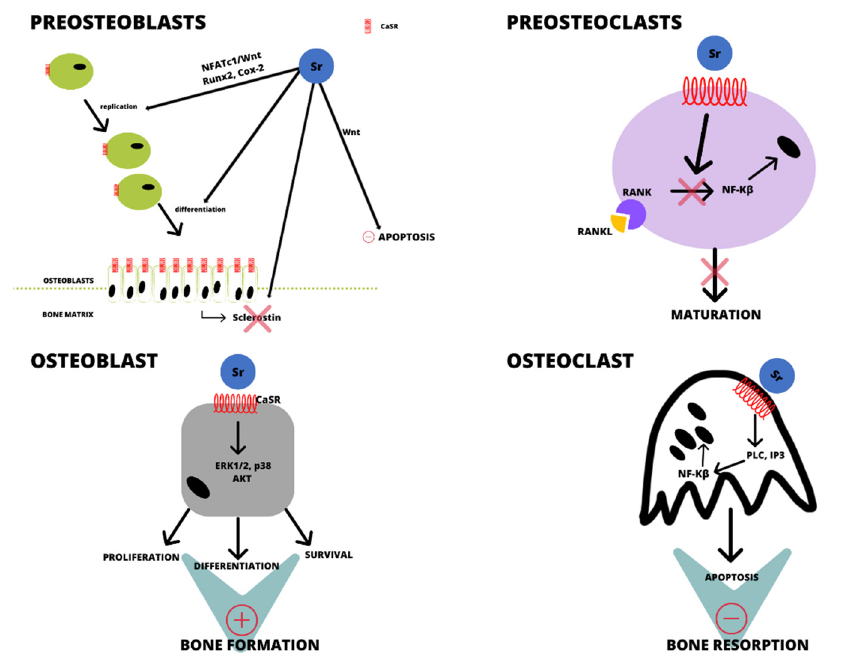
Figure 1. Effect of strontium on the function of osteoblasts and osteoclasts. Plus signs stimulation and minus signs inhibition.